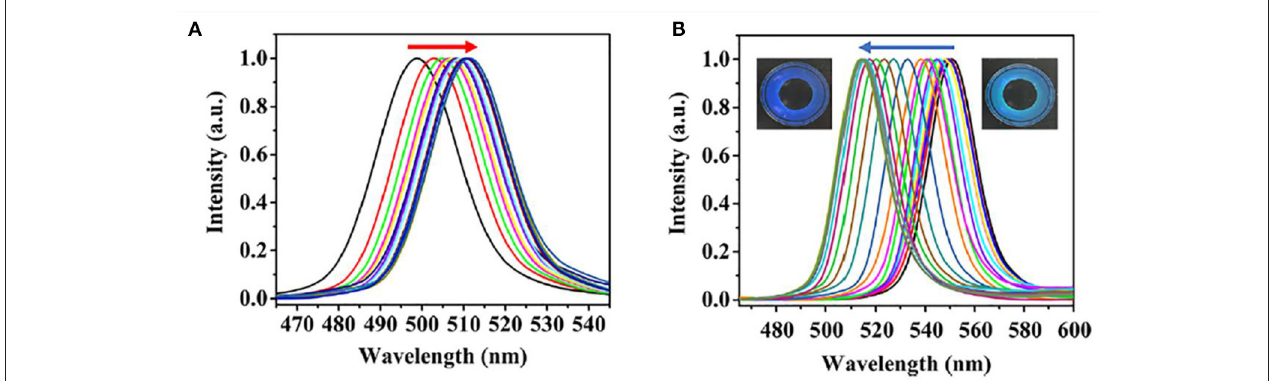
FIGURE 10 | Change of reflection peak of the lens during (A) drug loading in pH 6.5 timolol loading solution and (B) change of the reflection peak of the lens during drug release in artificial tear fluid (ATF) (reprinted with the permission of Deng et al., 2018; copyright 2018 American Chemistry Society).